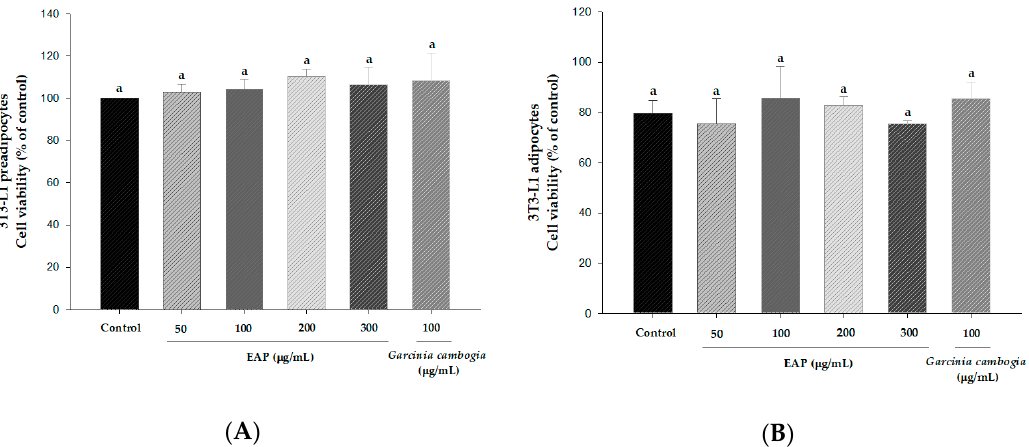
Figure 2. Effects of EAP water extract on cell viability of 3T3-L1 preadipocytes ( A ) and adipocytes ( B ). 3T3-L1 cells were treated with EAP water extract at various concentrations (50, 100, 200, and 300 µ g / mL) for 24 h ( A ) and seven days ( B ). Cell viability was measured by WST-1 assay. Values are presented as mean ± standard deviation. Differences between means were considered statistically significant at P < 0.05.